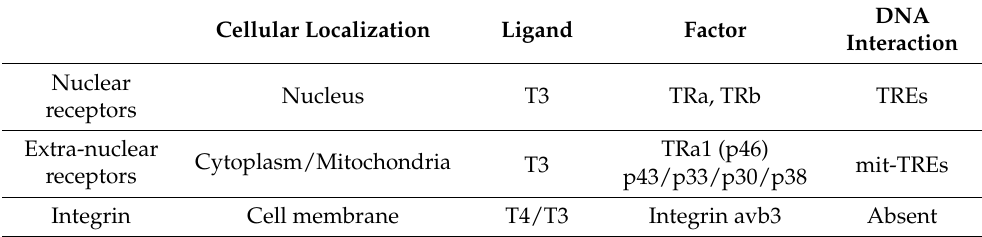
Table 1. Main factors mediating TH